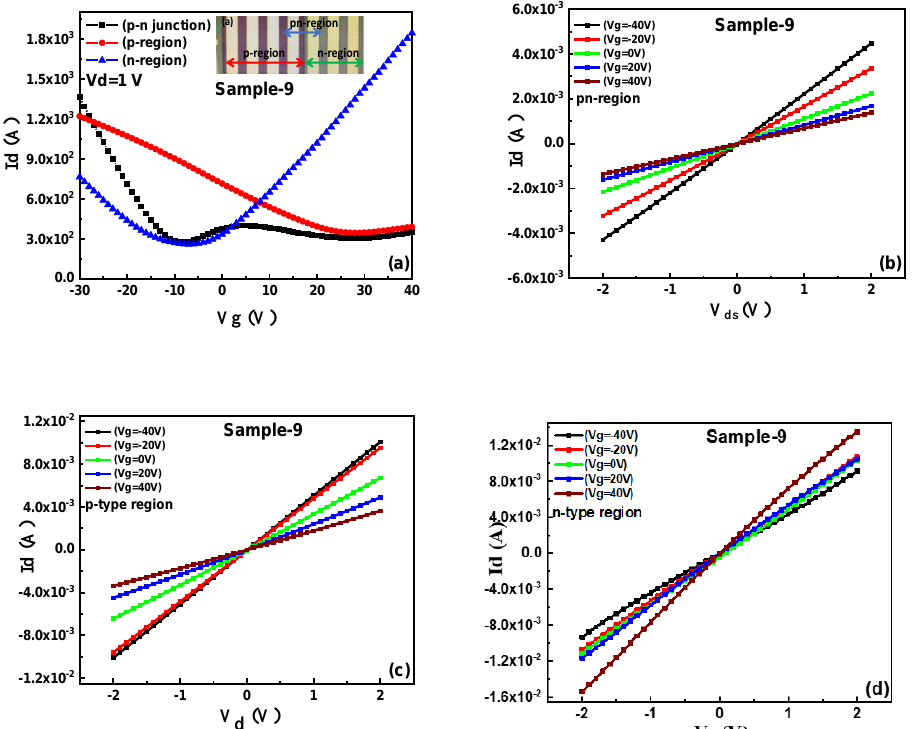
Figure 7. pn-junction: ( a ) Drain current (I d ), as a function of gate voltage for sample-9, showing transfer characteristics of the pn-junction region (black curve), p-region (red curve), and n-region (blue-curve). The pn-junction is a combination of p and n-type doped regions in a lateral channel of single-layer CVD graphene. ( b ) I d -V d characteristics of the pn-junction region in sample-9 at different gate voltages. ( c ) I d -V d characteristics of the p-region in sample-9, at different gate voltages. ( d ) I d -V d characteristics of the n-region in sample-9, at different gate voltages.